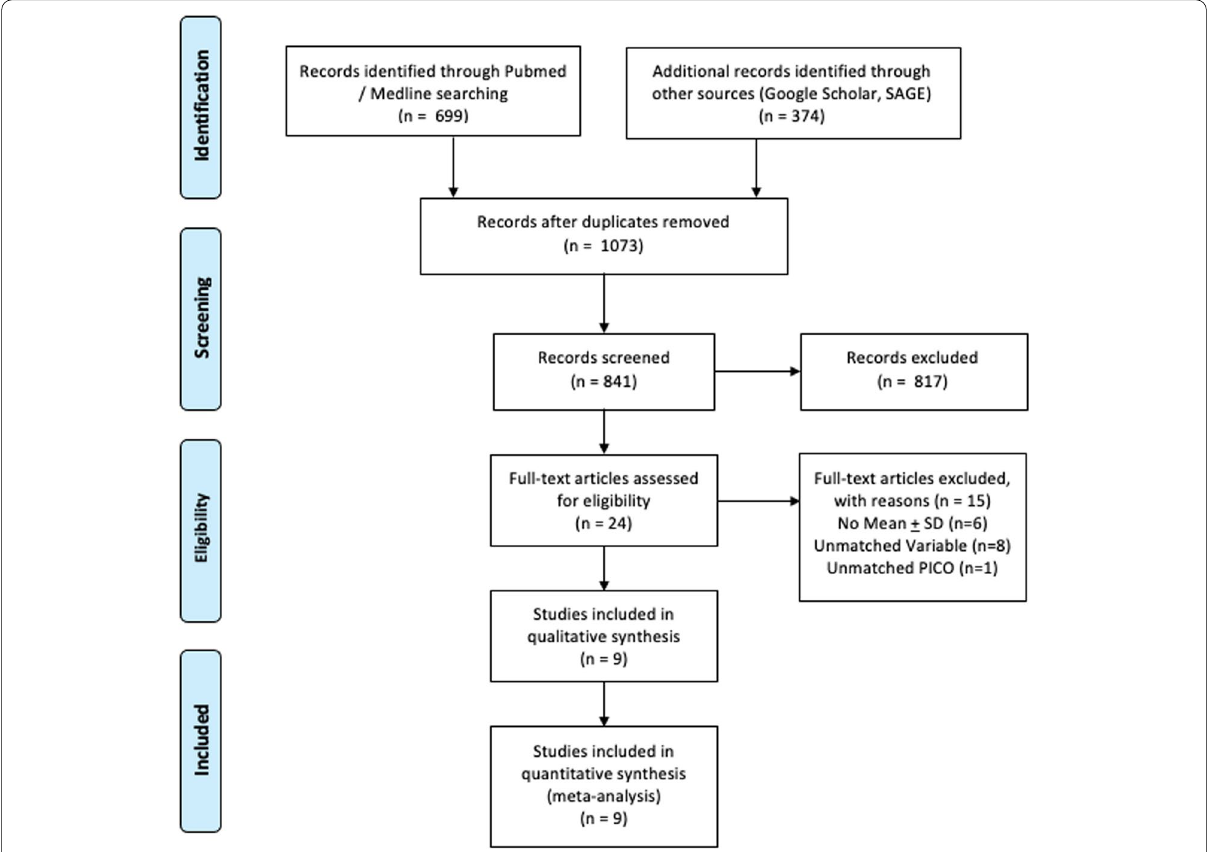
Fig. 1 PRISMA flowchart of studies’